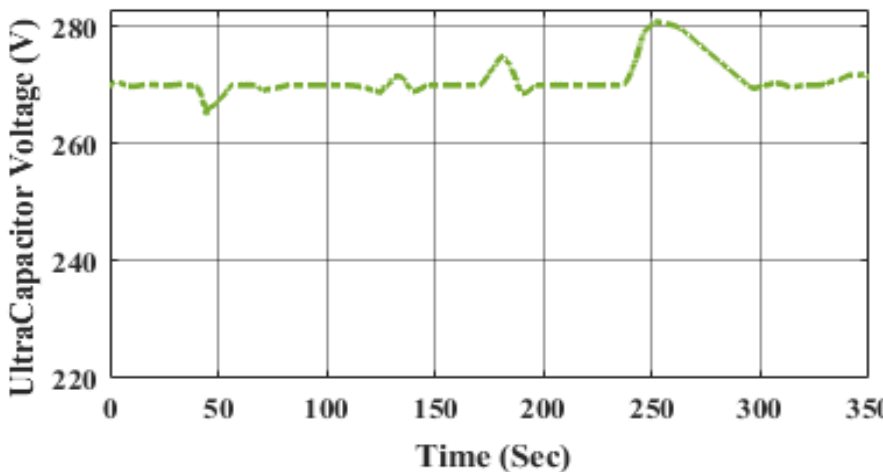
Figure 23. Time response of ultracapacitor voltage. Figure 24. Responses of ultracapacitor current.